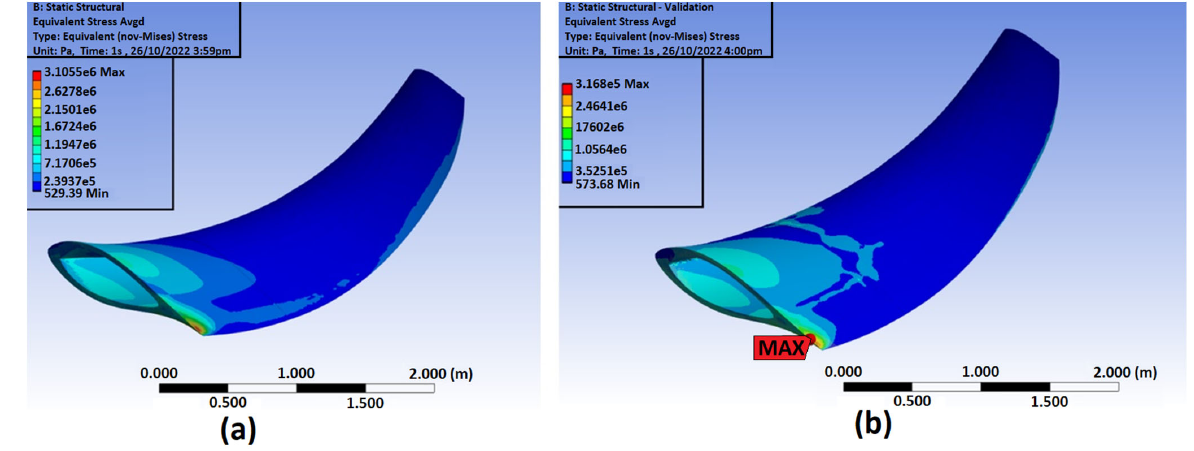
Figure 12. Comparative stress colormap. ( a ) Before TO, ( b ) after TO.